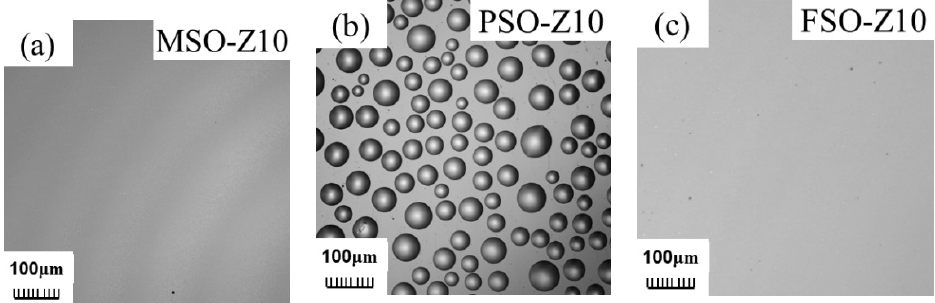
Figure 8. CLSM morphology of silicone oil/PDMS coatings: ( a ) MSO-Z10, ( b ) PSO-Z10, ( c ) FSO-Z10.